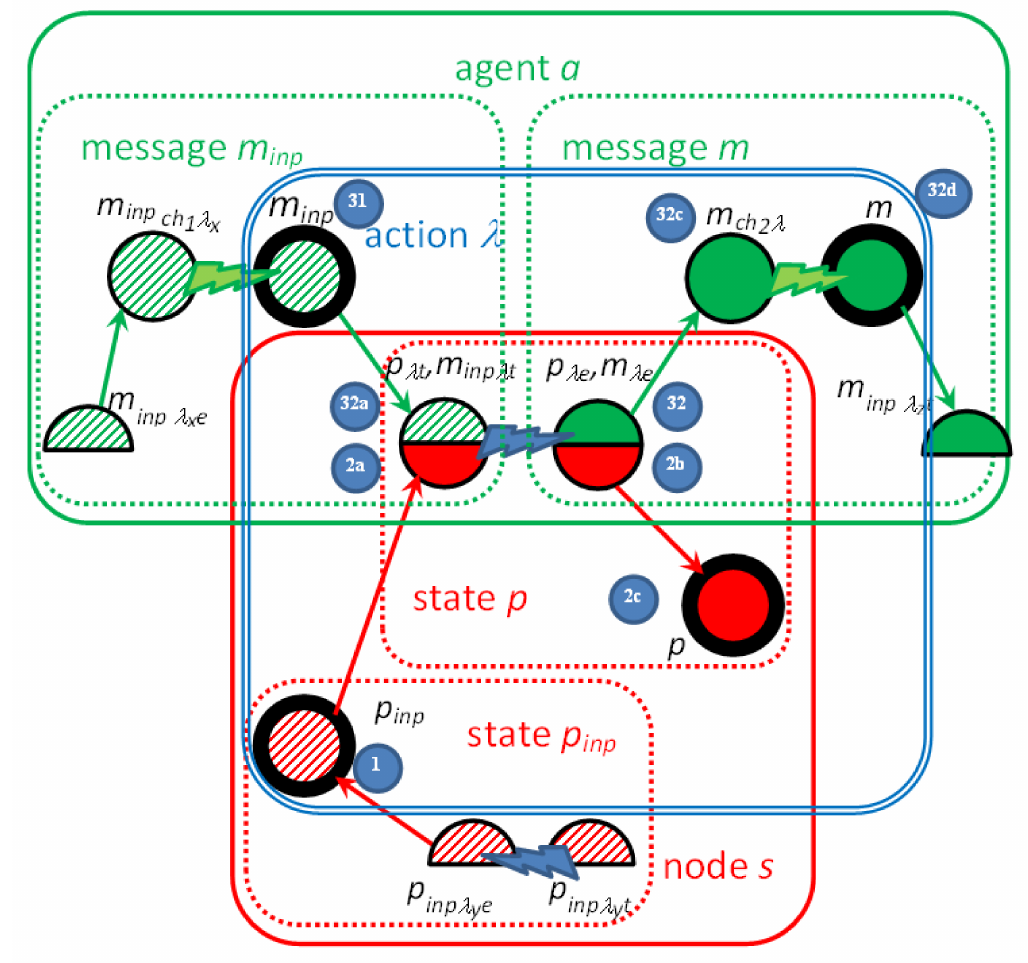
Figure 3. Illustration of the action λ = (( m inp ,p inp ),( m , p )) with its input elements: message m inp with derivatives and state p inp with derivatives. The message m inp is delivered by the action λ x and the state p inp by the action λ y . The input items of the action λ , λ x , and λ y , are also presented with their derivatives. The next action in agent a is λ z